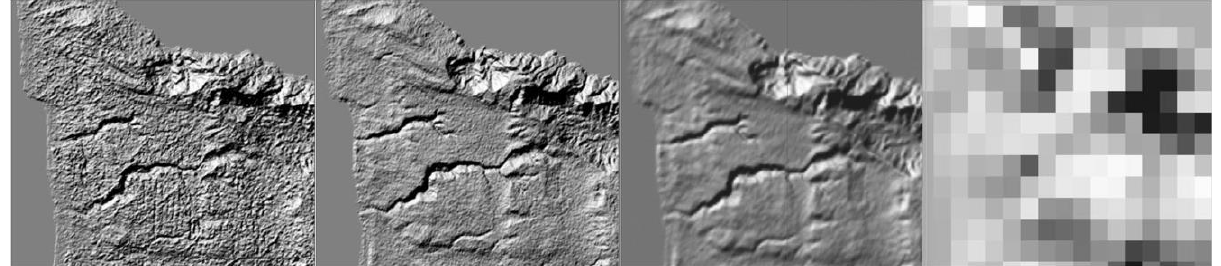
Figure 2. Fragments of collected DEMs in the form of hillshading images presented here in the 2x reduced resolution of SRTM-1 (approx. 60 m). From the left: ASTER, SRTM-1, SRTM-3, SRTM-30 SRTM-30 has a gridding structure with 30" postings (approximately 1 km), SRTM-3 about 100 m, SRTM-1 approximately 30 m and ASTER also 30 m ASTER model was abandoned because of the large jumps (noise) on flat areas. In Fig. 2 there are four DEMs presented at a scale of about 1:200 000 (visible noise in ASTER image first from the left) (Rodrigues et al., 2006, Karwel et al., 2008, Jacobsen, 2008, Crippen,